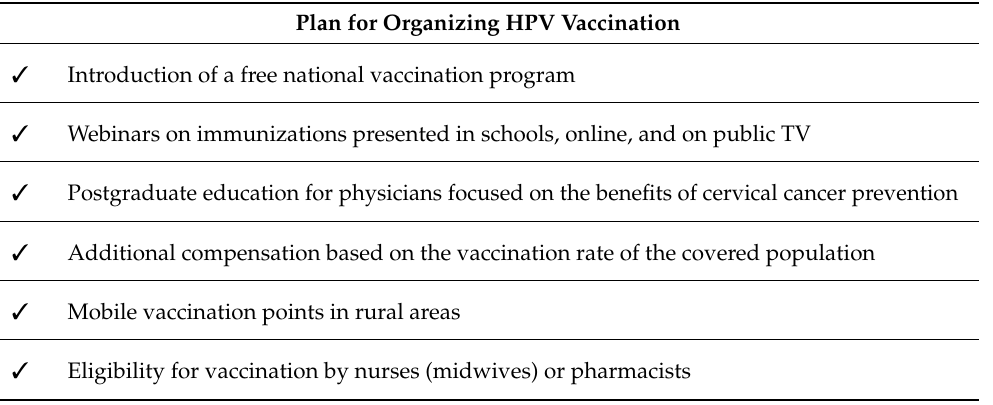
Table 12. Plan for organizing HPV